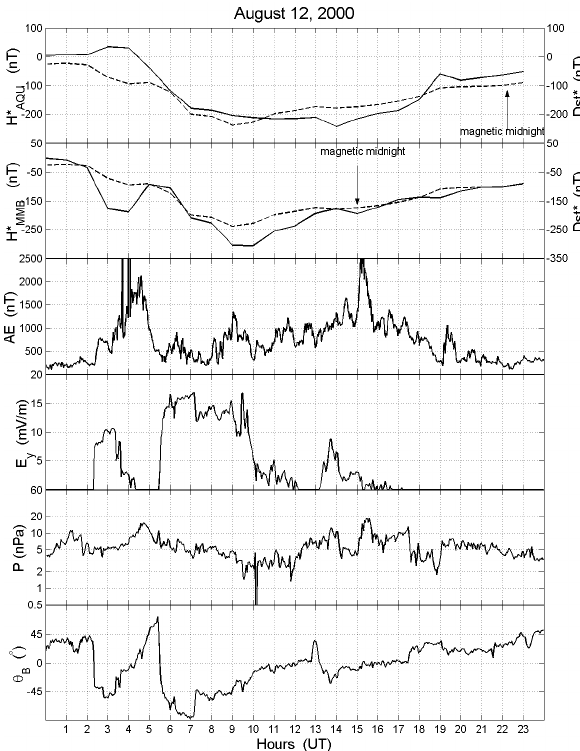
Fig. 5. From top to bottom the hourly values of the H * component at AQU and MMB (solid line) and the D st * index (dashed line), the AE index, the dawn-dusk solar wind electric field, the solar wind dynamic pressure and the interplanetary magnetic field θ angle for the 12 August 2000 event.